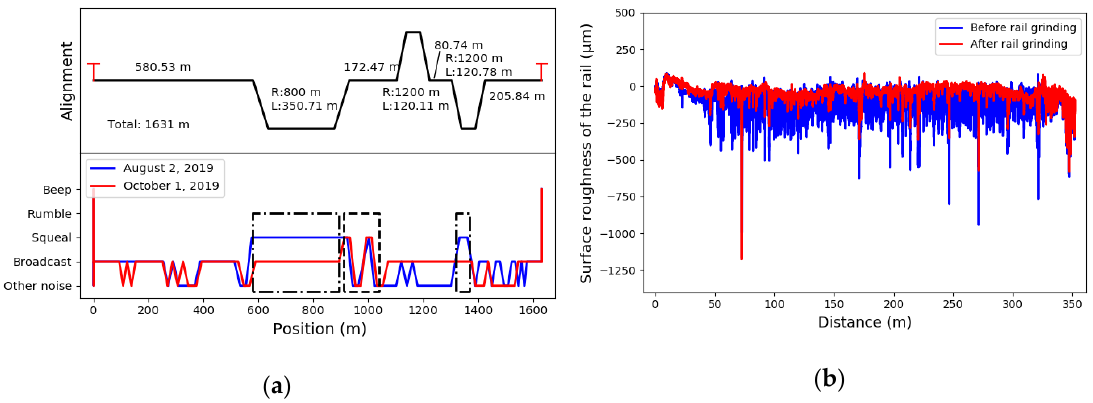
Figure 10. Statistical analysis of vehicle interior noise and dynamic responses: ( a ) The probability distribution curves of running speed ( v ); ( b ) The probability distribution curves of vertical acceleration ( a v ).